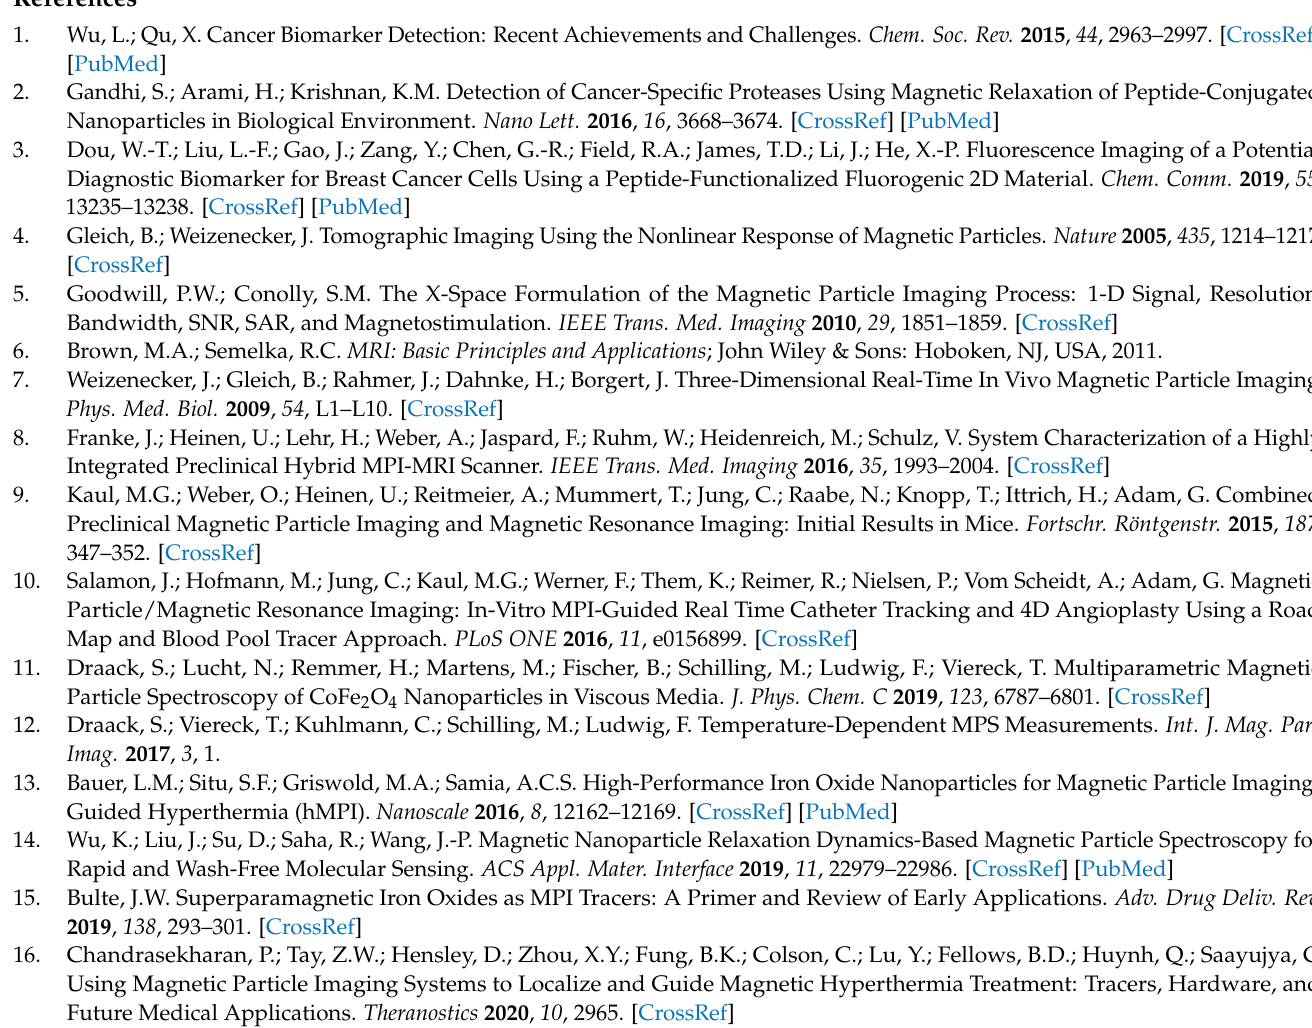
Clusters; Figure S5: DLS peaks of 2D-Clusters; Figure S6: Photographs of 2D-Clusters suspension at different time points of incubation with esterase enzyme at 37 ◦ C; Figure S7: MPI measurements of single-core IONCs in an isolated and 3D configuration in comparison to the 2D-Clusters and the Std; Figure S8: Magnetic characterization of the single IONCs in comparison to 2D-Clusters; Figure S9: Linear magnetic relaxation slopes of 2D-Clusters at different time points of incubation with